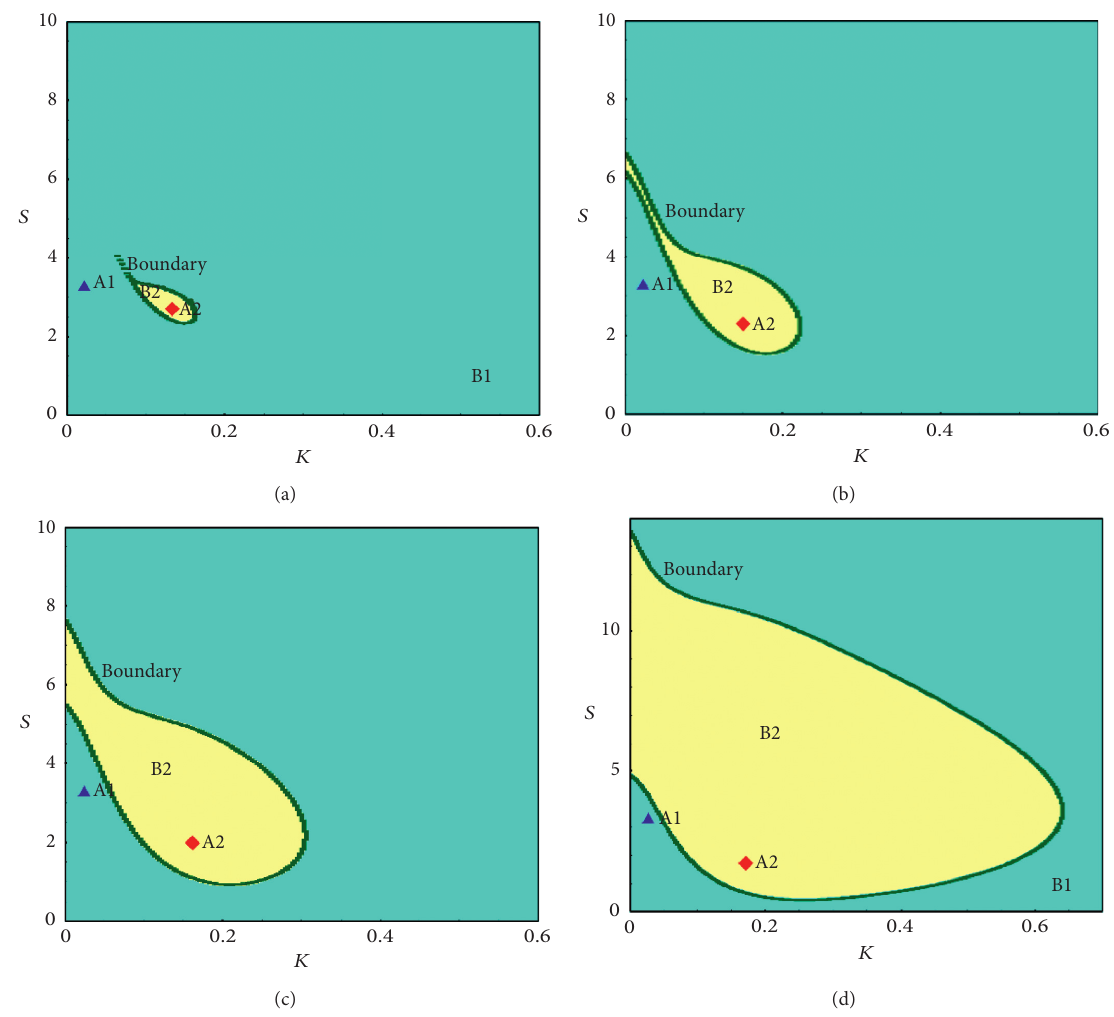
Figure 4: The global dynamic character of system (4): b